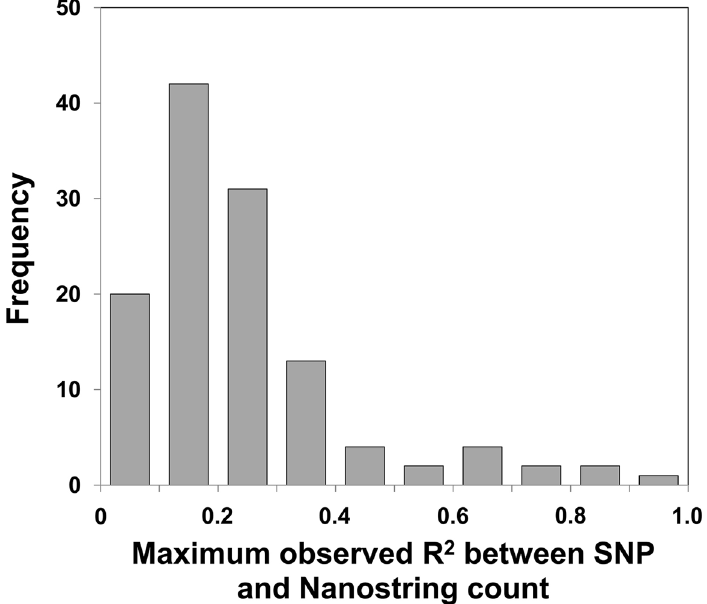
Figure 3. Most multicopy genes show very low levels of linkage disequilibrium with nearby SNPs. Correlation analysis for each of the 121 polymorphic probes targeting multicopy genes and macrosatellites with SNP markers within 6 250 kb yielded a median R 2 =0.18 between the highest ranked filtered SNP and probe count. Only 3 of 116 ( , 3%) multicopy genes showed an R 2 $ 0.8 with any SNP in the three populations studied. Therefore the vast majority of tandem repeat variations lack informative tag SNPs, and thus association studies of multicopy loci require specific genotyping of each locus to gain accurate copy number information of these regions.